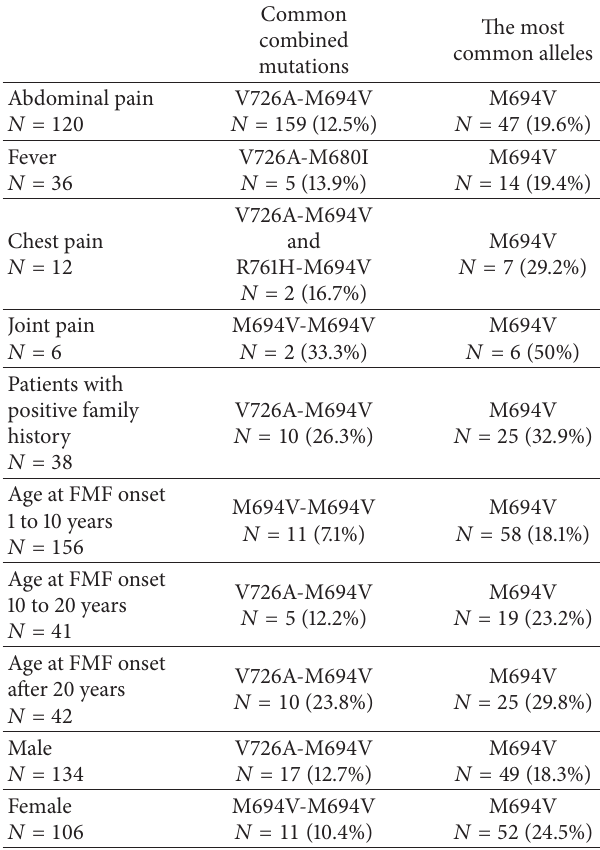
Table 2: Results of MEFV genes mutations and different allele’s analysis.